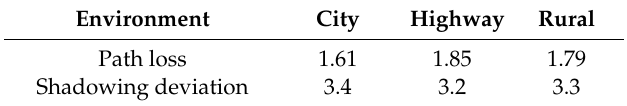
Table 3. Parameters. MAC: Medium Access Control.